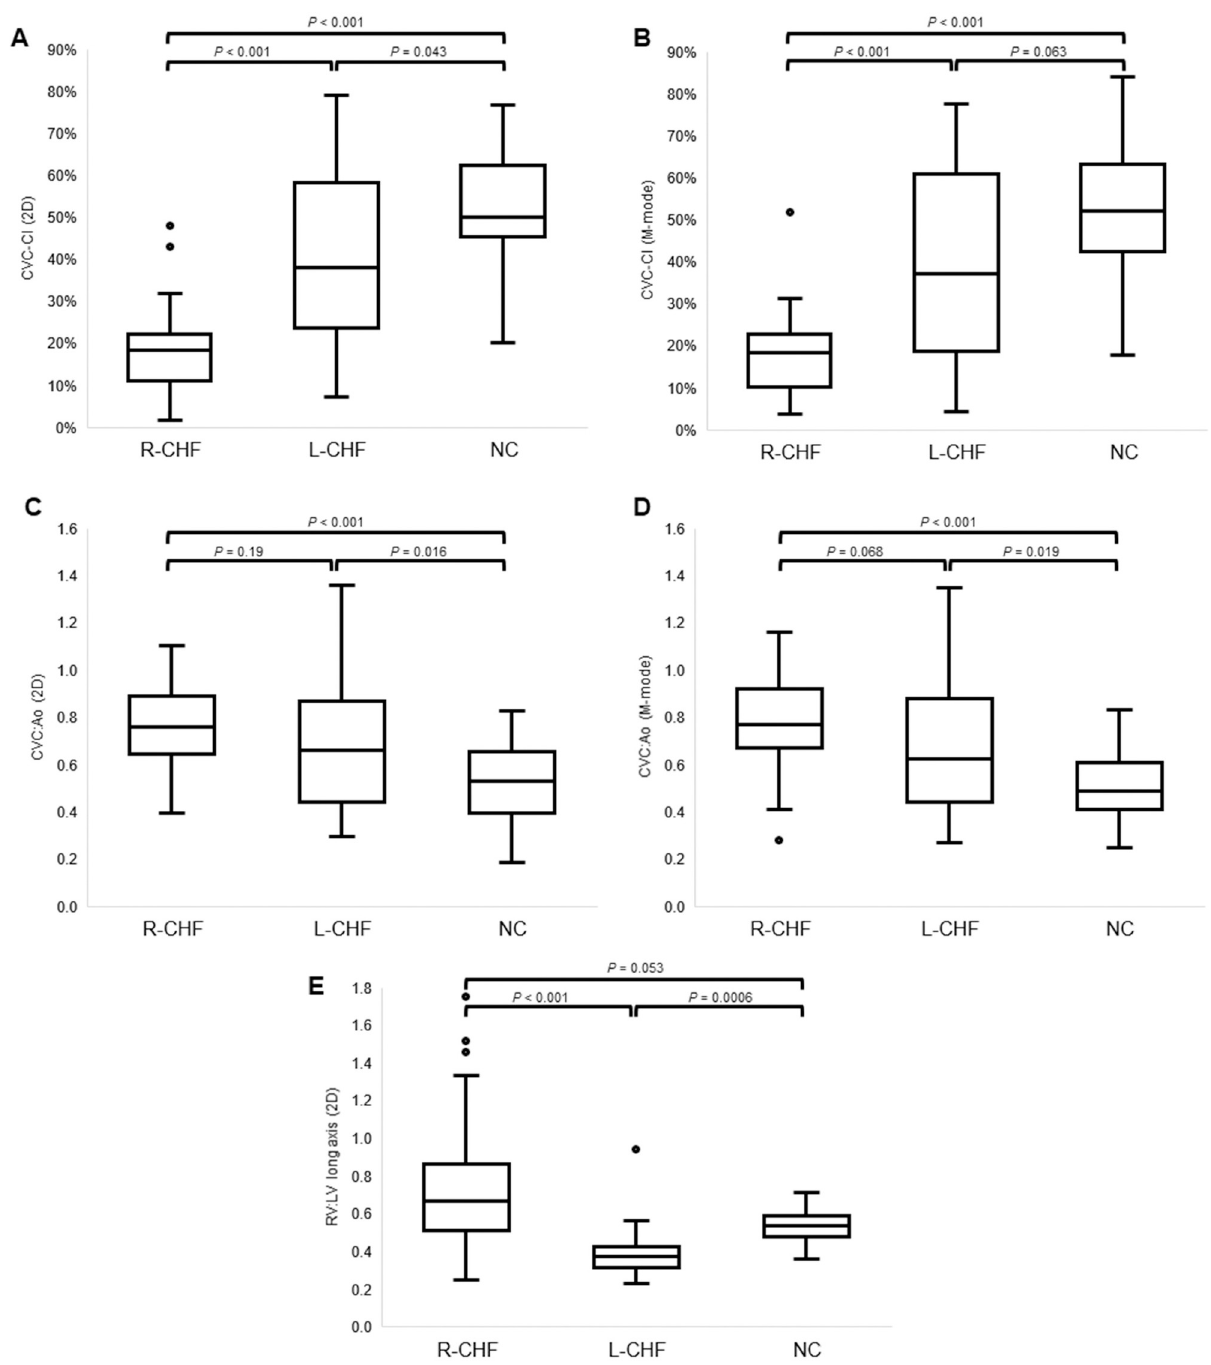
Fig 1. Selected ultrasound indices by study group. Box and whisker plots of data of select ultrasound indices obtained from 113 dogs with cavitary effusion or pulmonary edema diagnosed with either right-sided congestive heart failure (R-CHF, n = 51, including 17 dogs with pericardial effusion and tamponade), left-sided congestive heart failure (L-CHF, n = 30), or noncardiac causes of cavitary effusion (NC, n = 32). A, caudal vena cava collapsibility index (CVC-CI) in 2D; B, caudal vena cava collapsibility index in M-mode; C, maximum caudal vena cava to aorta ratio (CVC:Ao) in 2D; D, maximum caudal vena cava to aorta ratio (CVC:Ao) in M-mode; E, ratio of right ventricular to left ventricular dimension (RV:LV) in long axis. Boxes represent the interquartile range while the horizontal line in each box represents the group median; whiskers represent the 5th and 95th percentiles, and the outliers are plotted as